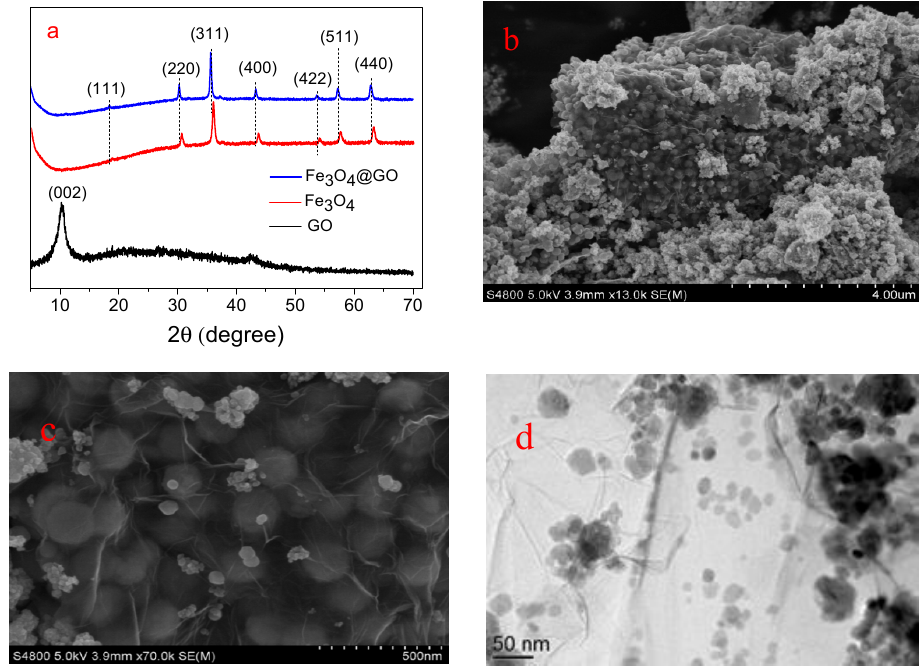
Figure 1. ( a ) XRD spectra for GO, Fe 3 O 4 , and Fe 3 O 4 @GO; ( b ) SEM images of Fe 3 O 4 @GO; and ( c , d ) TEM images of Fe 3 O 4 and Fe 3 O 4 @GO, respectively.